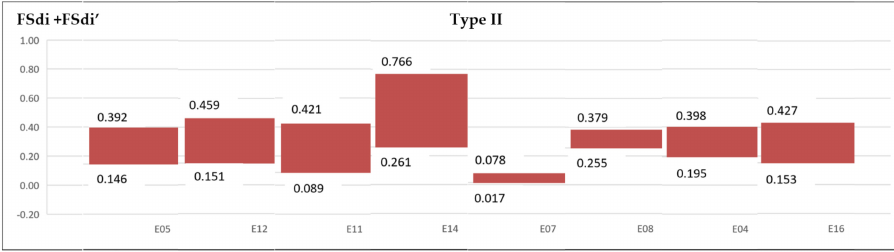
Figure 13. Area delamination factor range Type II (FSdi + FSdi’).